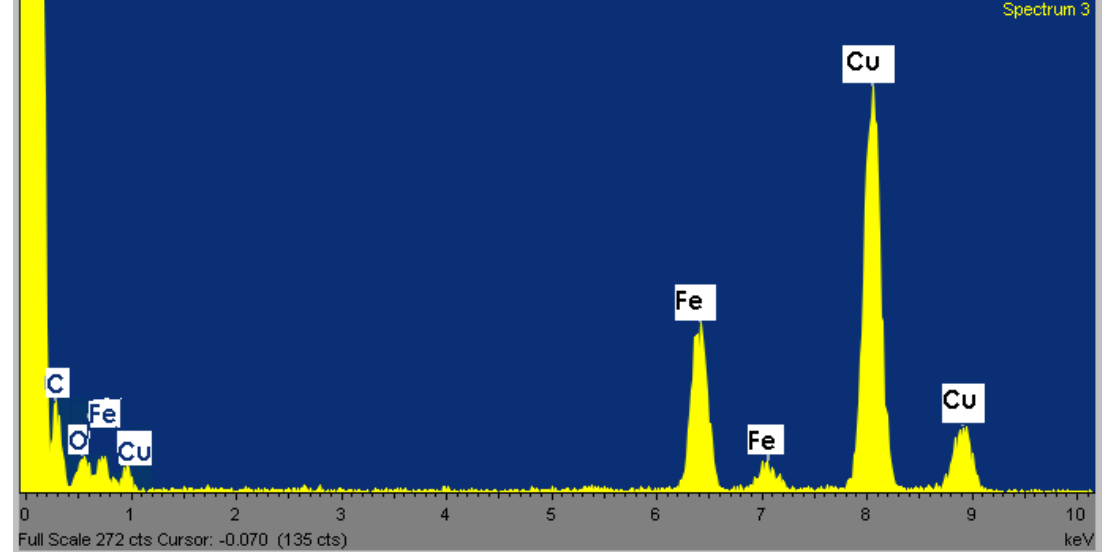
Figure 3. Energy dispersive X-ray spectroscopy (EDS) analysis of the monodisperse spheres from Figure